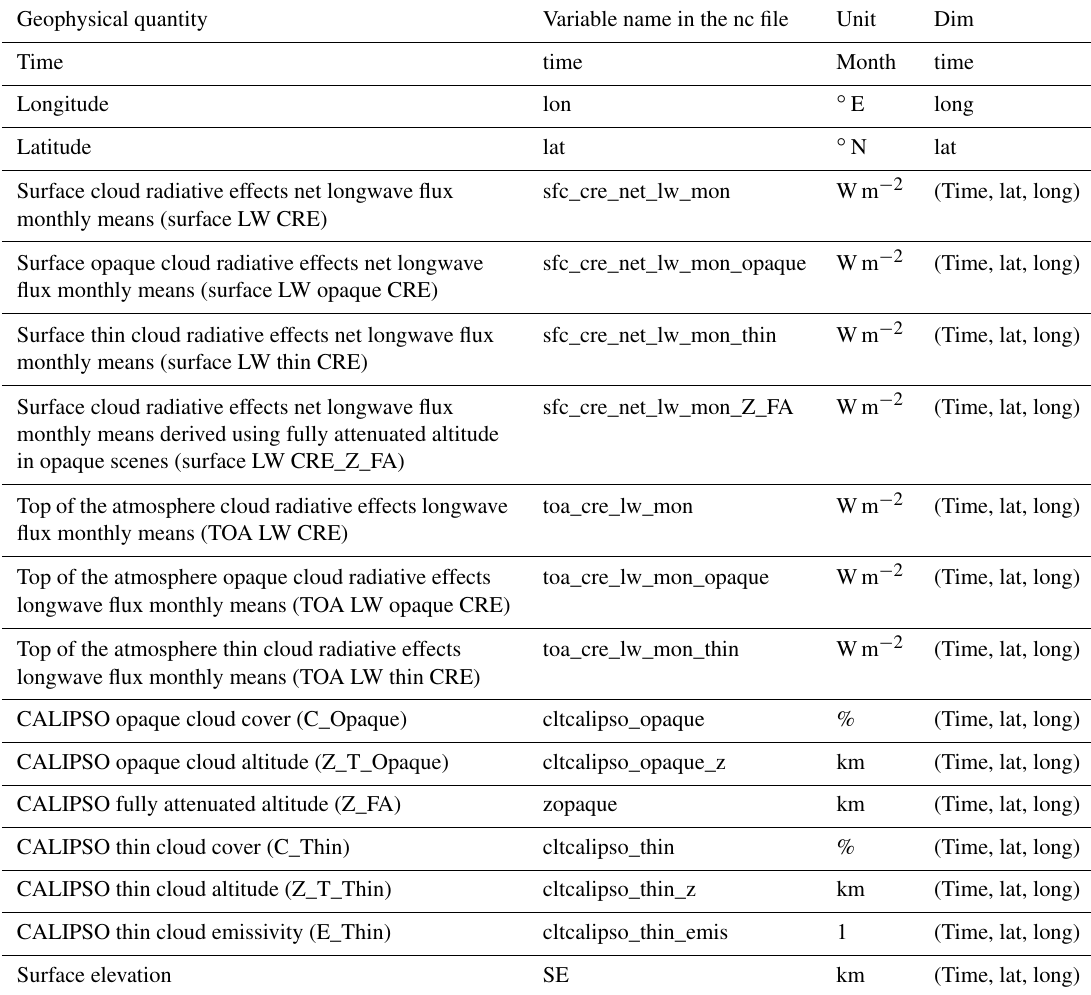
Table C1. LWCRE–LIDAR–Ed1 monthly gridded products: definitions and variable